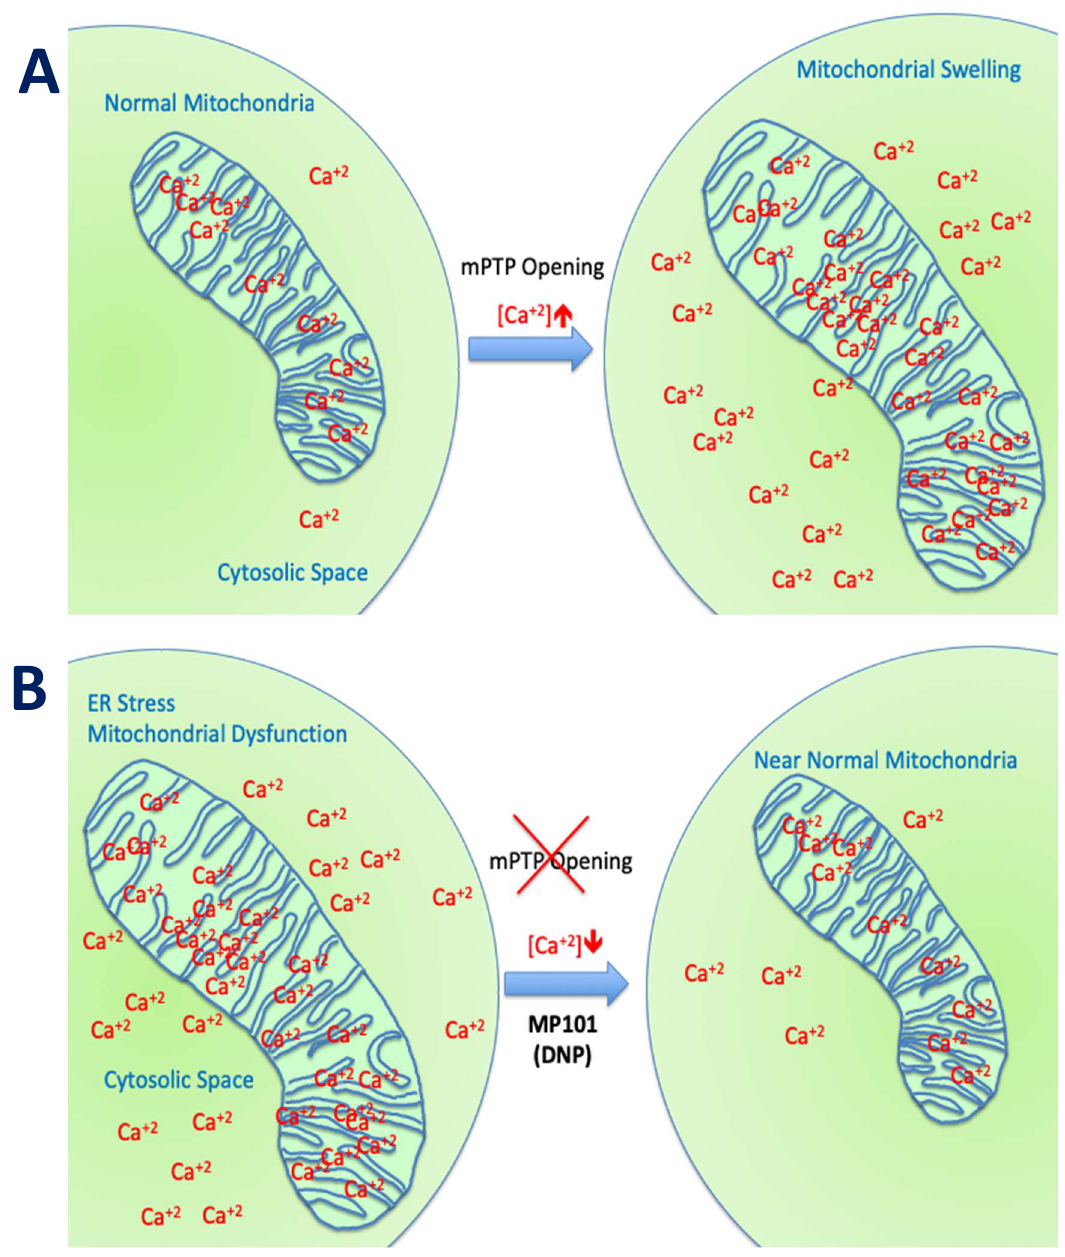
Figure 3. Calcium overload and DNP. ( A ) The cytosolic Ca 2+ under normal conditions is kept low and released from the mitochondria for signaling [1]. However, for conditions related to unfolded protein response (UPR) that lead to ER stress such as Huntington Disease [41,42] or mutations directly of ER function such as Wolfram Syndrome [43] or loss of dystrophin in the case of Duchenne Muscular Dystrophy [44], calcium levels rise in the cytosol and subsequently in the mitochondria. If the threshold for mitochondrial Ca 2+ storage is exceeded, the mitochondrial permeability transition pore (mPTP) is formed and the mitochondria are destroyed setting up a cascade for neighboring mitochondrial destruction [16]. ( B ) Calcium overload of the mitochondria may be reduced, even in the presence of a sudden rise of cytosol Ca 2+ from the ER, in TBI and other conditions of metabolic stress, in the presence of DNP by closing the calcium uniporter channel. Reduced intra-mitochondrial calcium removes the driving force toward apoptosis, thereby saving the neuron, myotube and other at-risk cell types.